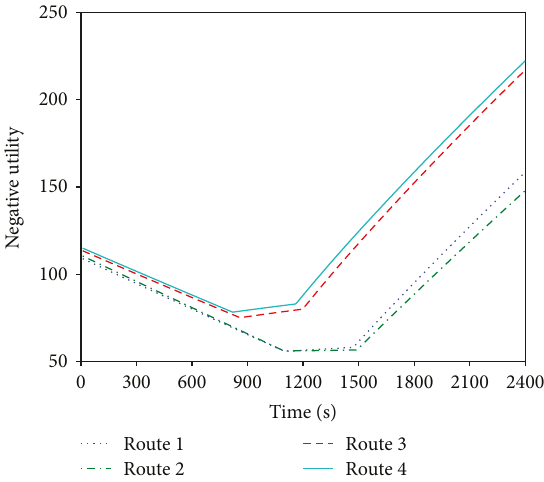
Figure 8: The relationship between departure time and negative utility of the